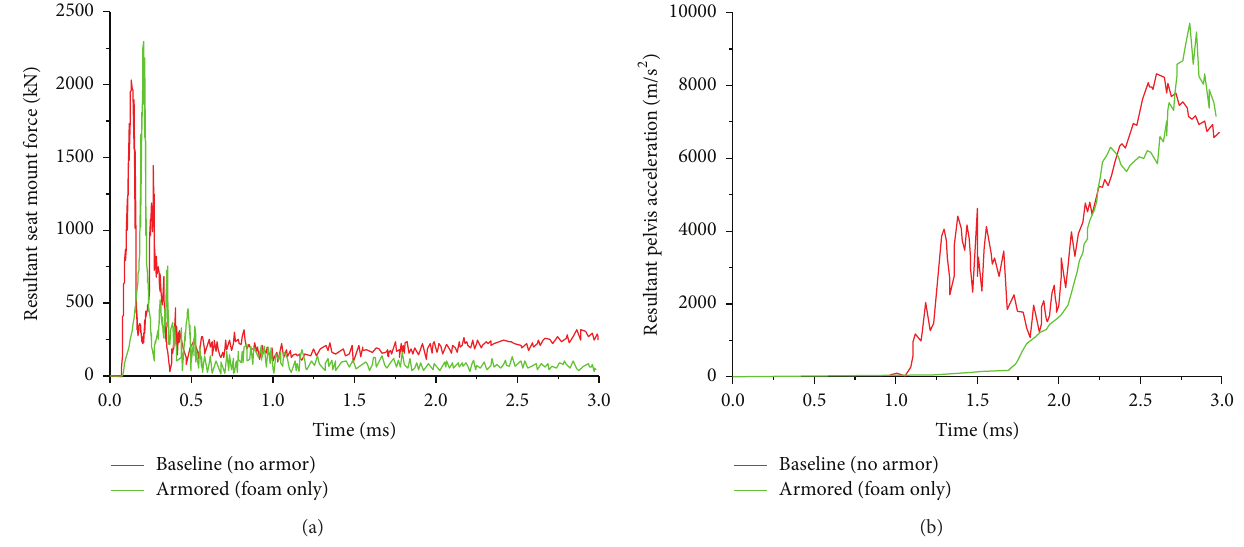
Figure 7: Comparison of blast-resistant capabilities of various designs with 4kg TNT equivalent. (a) Seat mounts forces. (b) Crew pelvis